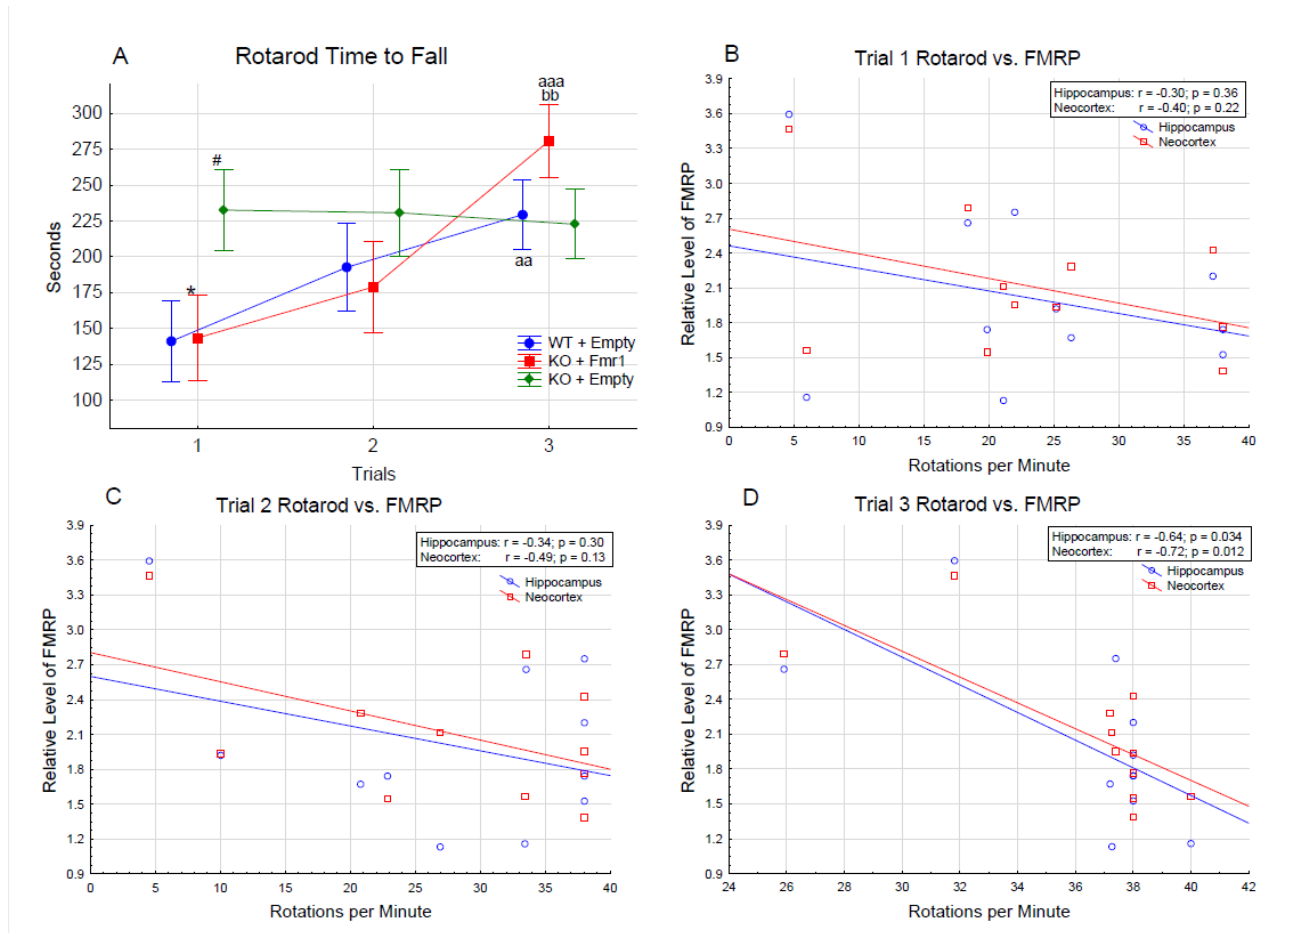
Figure 6. ( A ) Accelerating rotarod. The difference in the time to fall (in seconds) between the treatment groups over the 3 trials of the rotarod test. Differences from the WT + Empty group are shown by # = p < 0.05, ## = p < 0.01, and ### = p < 0.001. Differences from the KO + Empty group are shown by * = p < 0.05, ** = p < 0.01, and *** = p < 0.001. Differences from the first trial are shown by a = p < 0.05, aa = p < 0.01, and aaa = p < 0.001. Differences from the second trial are shown by b = p < 0.05, bb = p < 0.01, and bbb = p < 0.001. Correlations of rotarod performance with FMRP levels in hippocampus and neocortex of individual mice in trial 1 — ( B ), trial 2 — ( C ), and trial 3 — ( D ).